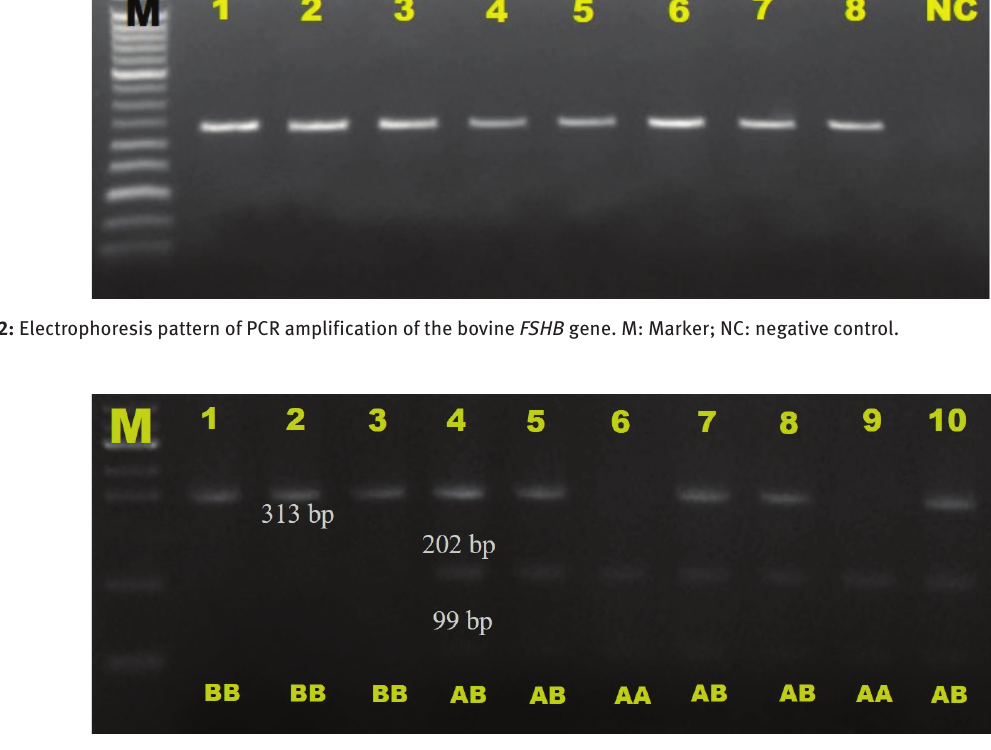
Figure 3: Electrophoresis pattern of Pst I enzyme digestion. M: Marker.